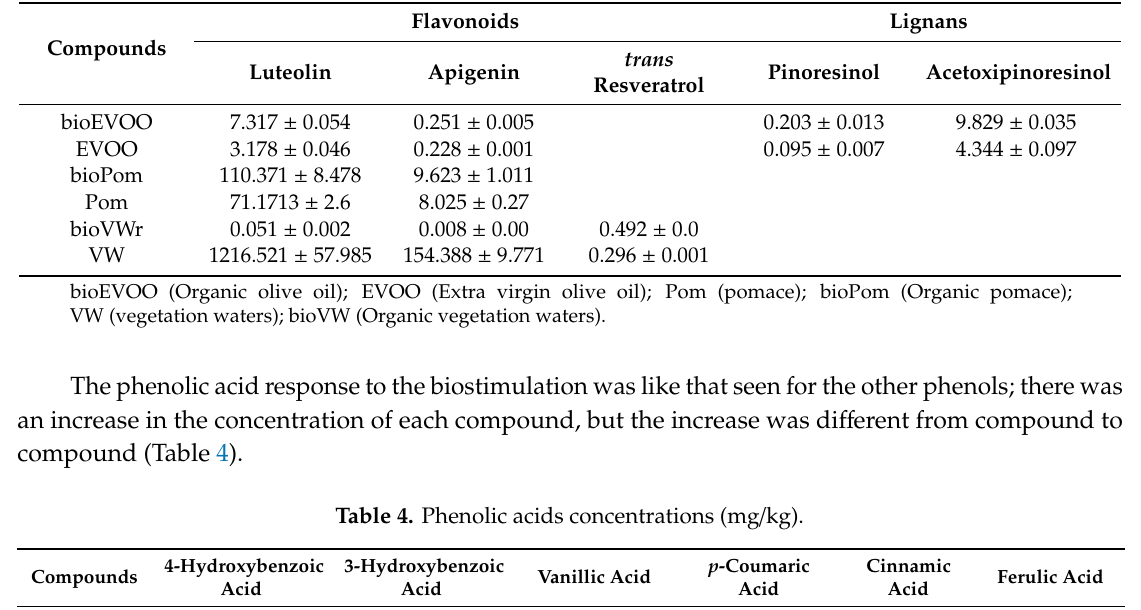
Table 3. Flavonoids and lignans concentrations (mg / kg).